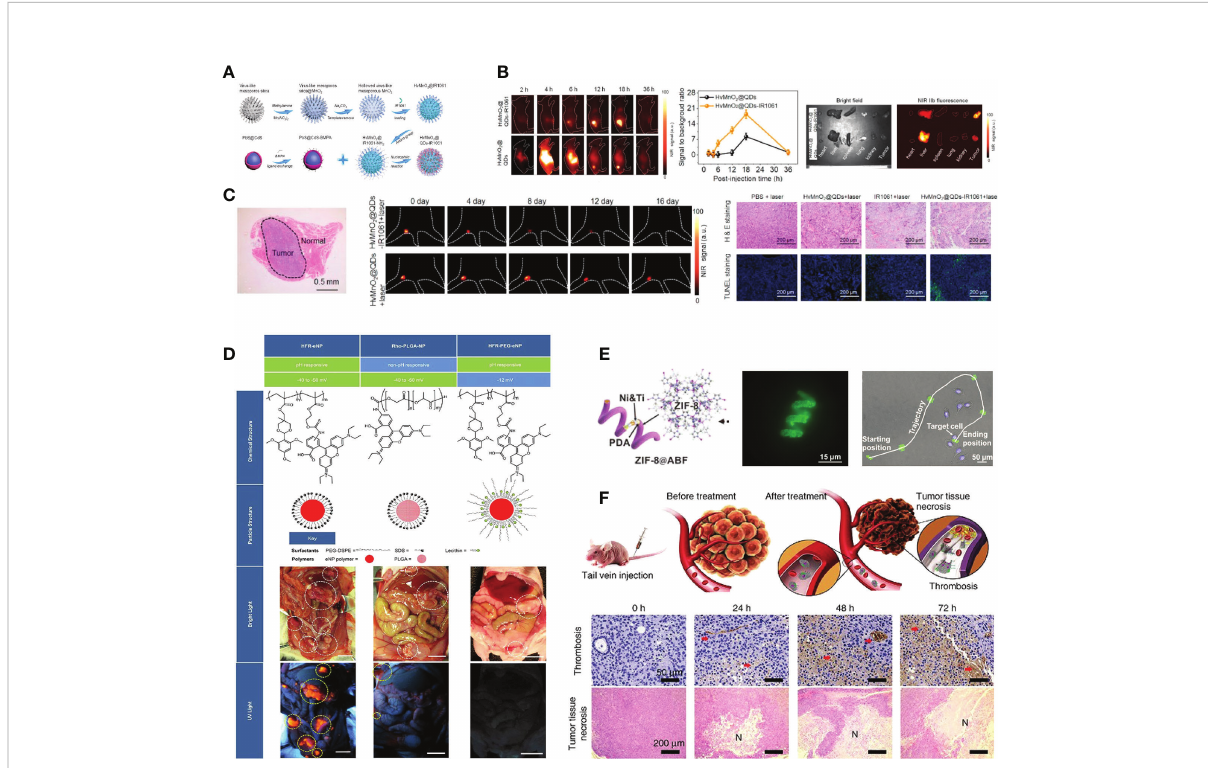
FIGURE 2 Nanotechnology improves the effect of surgical therapy. (A) Model diagram of NIR-IIb quantum dots anchored and IR1061 loaded hollow virus- bionic MnO2 (45). Adapted with permissions from ref (45). Copyright 2022, Elsevier. (B) The fi rst two fi gures show the NIR-IIb fl uorescence images of 4T1 breast tumor bearing mice after tail vein injection of HvMnO2@QDs-IR1061 and HvMnO2@QDs for different time points and corresponding SBR. The third fi gure shows the bright fi eld image (left) and ex vivo NIR-IIb fl uorescent image (right) of major organs and tumors after 6 h tail vein injection of HvMnO2@QDs-IR1061 (upper layer) and HvMnO2@QDs (down layer), respectively (45). Adapted with permissions from ref (45). Copyright 2022, Elsevier. (C) H & E images of the lymph node metastasis dissection with aid of NIR-IIb fl uorescence imaging after tail vein injection of HvMnO2@QDs-IR1061 for 18 h, NIR-IIb fl uorescence images of lymph node metastasis after administration of HvMnO2@QDs-IR1061 + laser or HvMnO2@QDs + laser and H & E and TUNNEL images of metastases after different treatments for 4 days